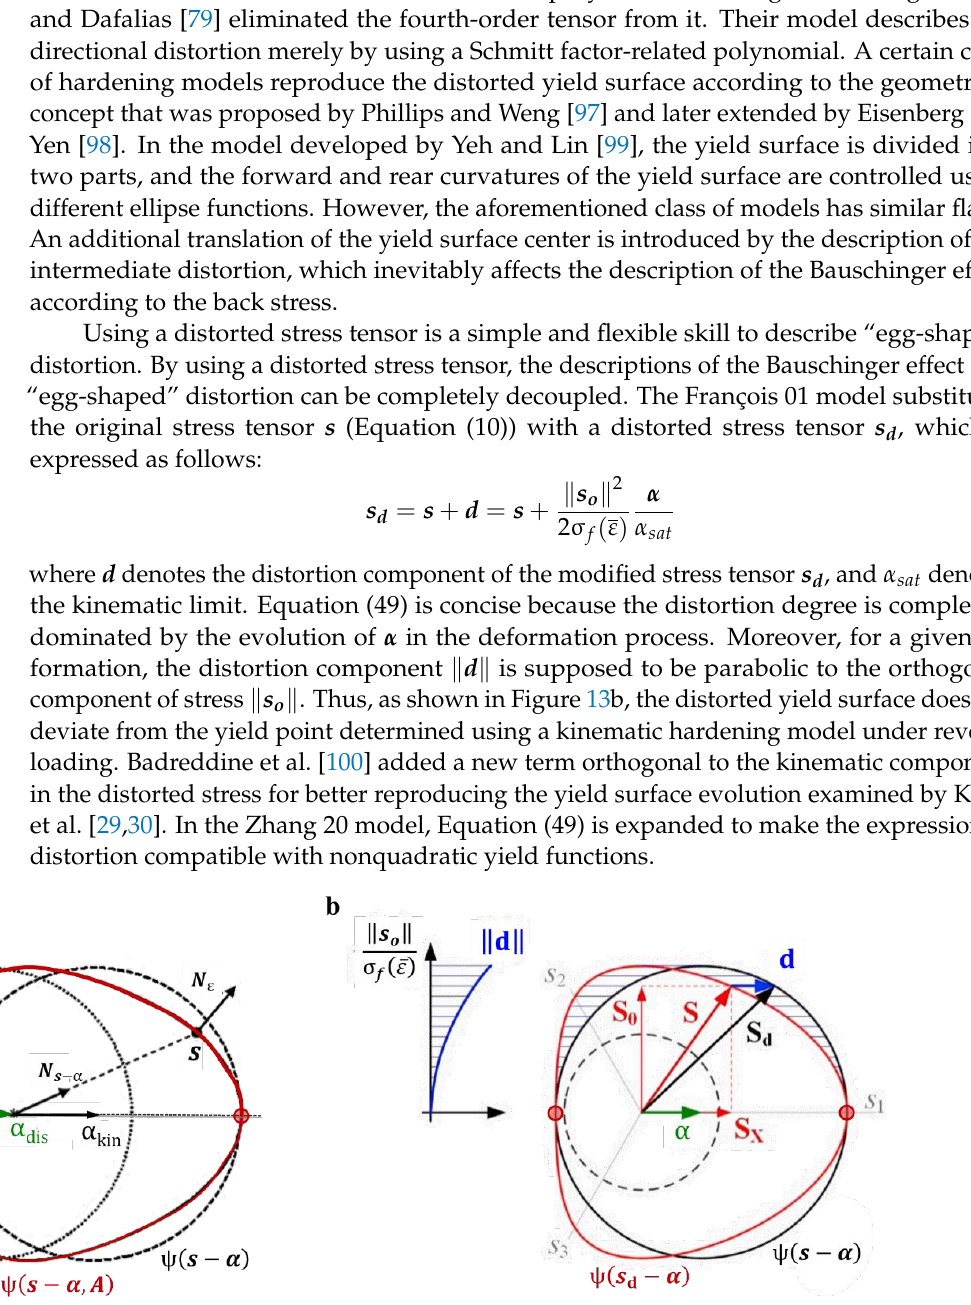
Figure 11. Evolution of the normalized yield surface in the Noman 10 model in the cases of ( a ) pro- portional loading and ( b ) continuous loading path changes . Reprinted with permission from Ref.